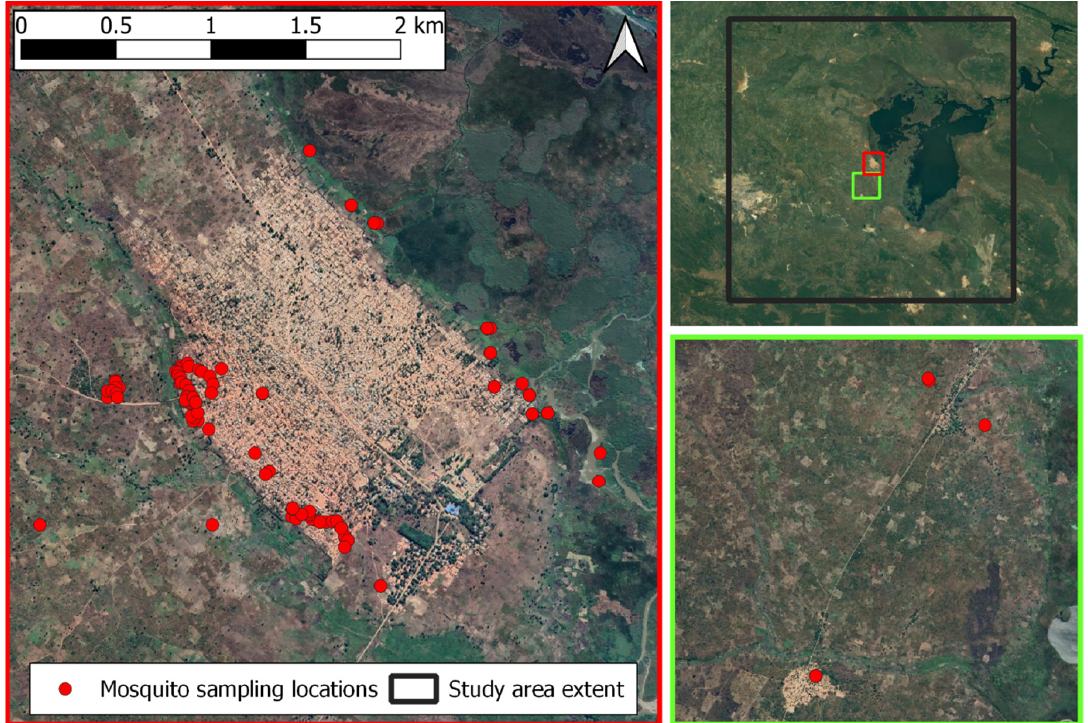
Figure 3. Mosquito sampling locations in Kapolowe. Survey locations are predominantly located outside or on the edges of Kapolowe, in close proximity to a mix of habitat types typically found across the broader study area.